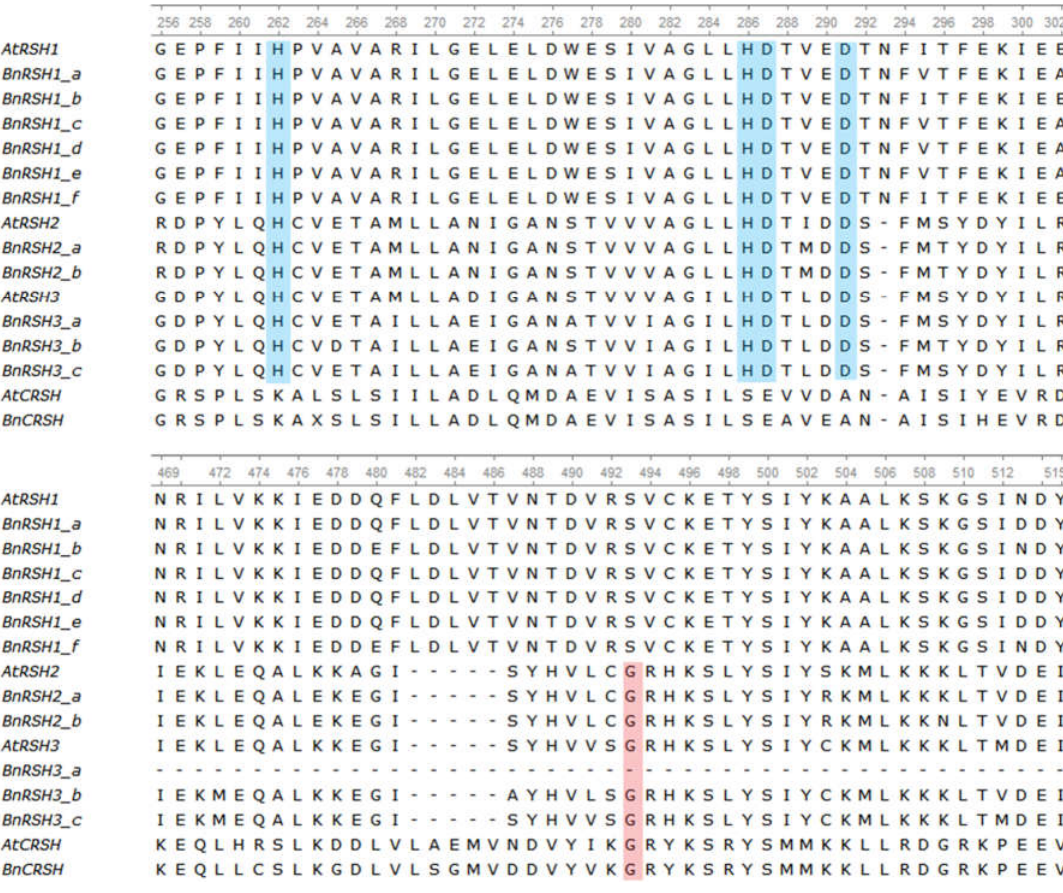
Figure 4. Amino acid alignments for the (p)ppGpp hydrolase HD (upper part) and synthetase SYNTH (lower part) domains of the RSH1, RSH2, RSH3, and CRSH proteins in A. thaliana and B. napus . In the HD domain the His (H) and Asp (D), important for its hydrolysis activity, are highlighted in blue. In the SYNTH domain the Gly (G), important for its synthetase activity, is highlighted in pink.